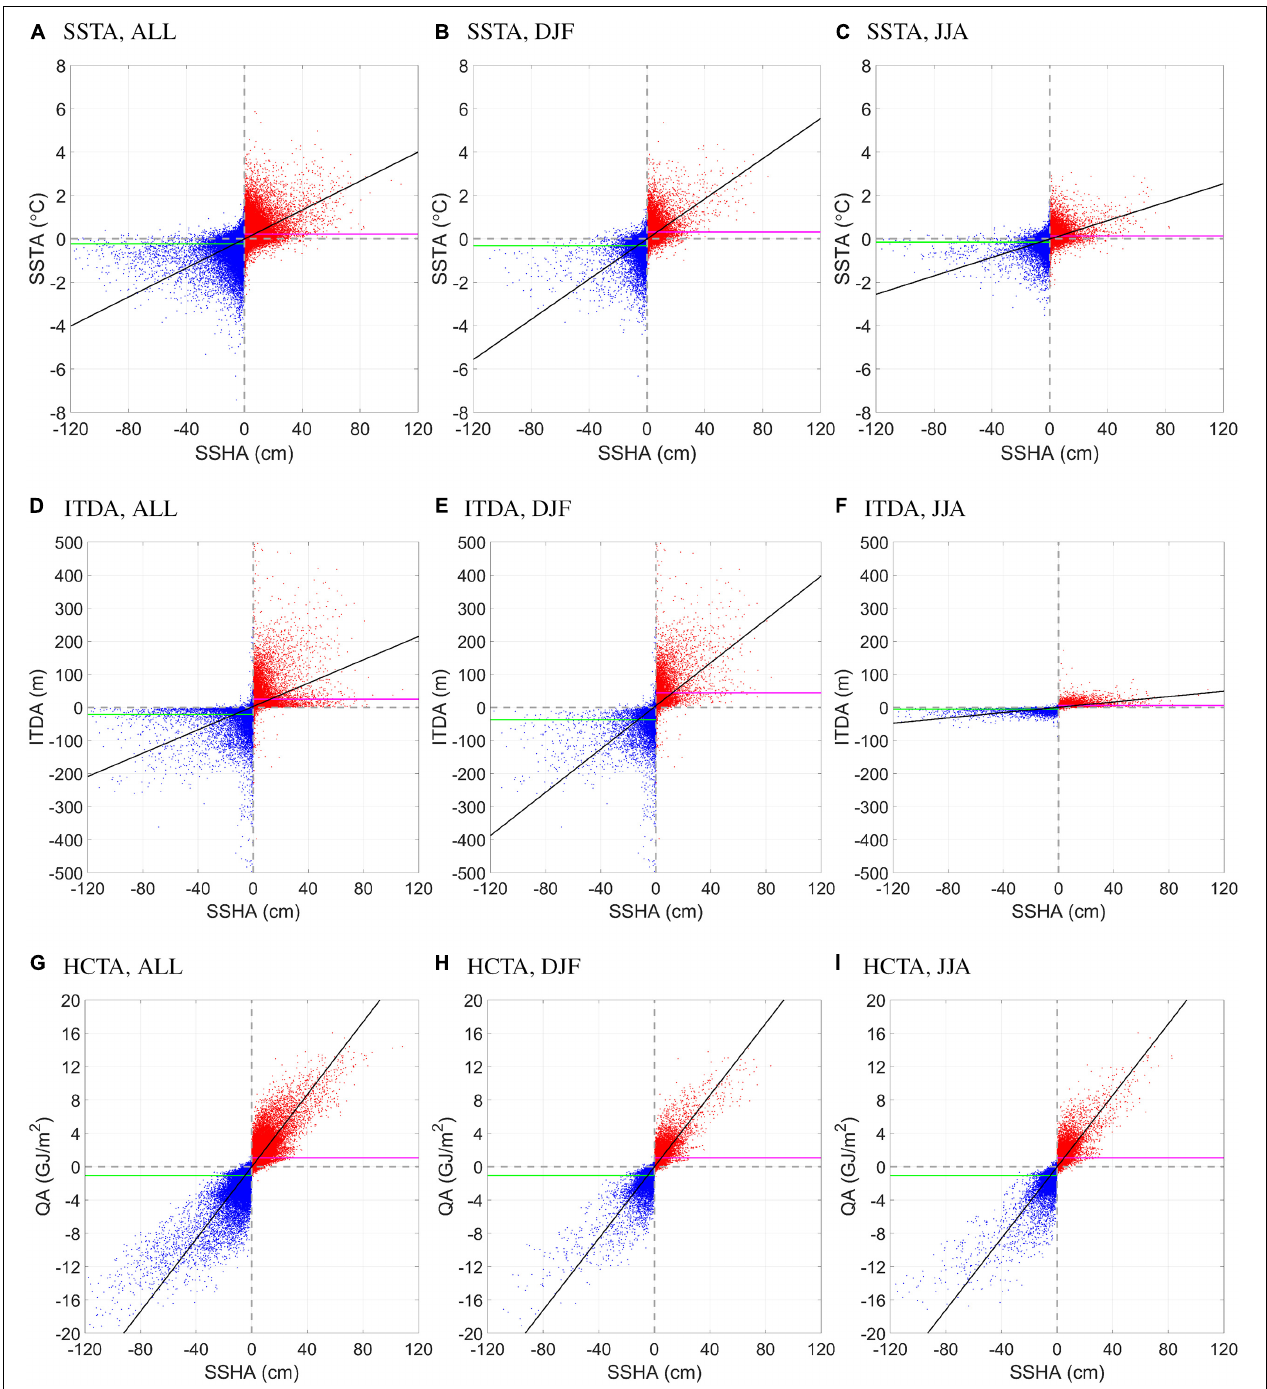
FIGURE 7 | Scatter plots showing statistical relationship between eddy amplitude (SSHA, cm) and (A–C) SSTA ( ◦ C), (D–F) ITDA (m), (G–I) HCTA (GJ/m 2 ) over all time (1st column), winter (DJF, second column), and summer (JJA, last column). The magenta (green) line represents the average over all anticyclonic (cyclonic) eddies. The black line is the linear relationship calculated by least square